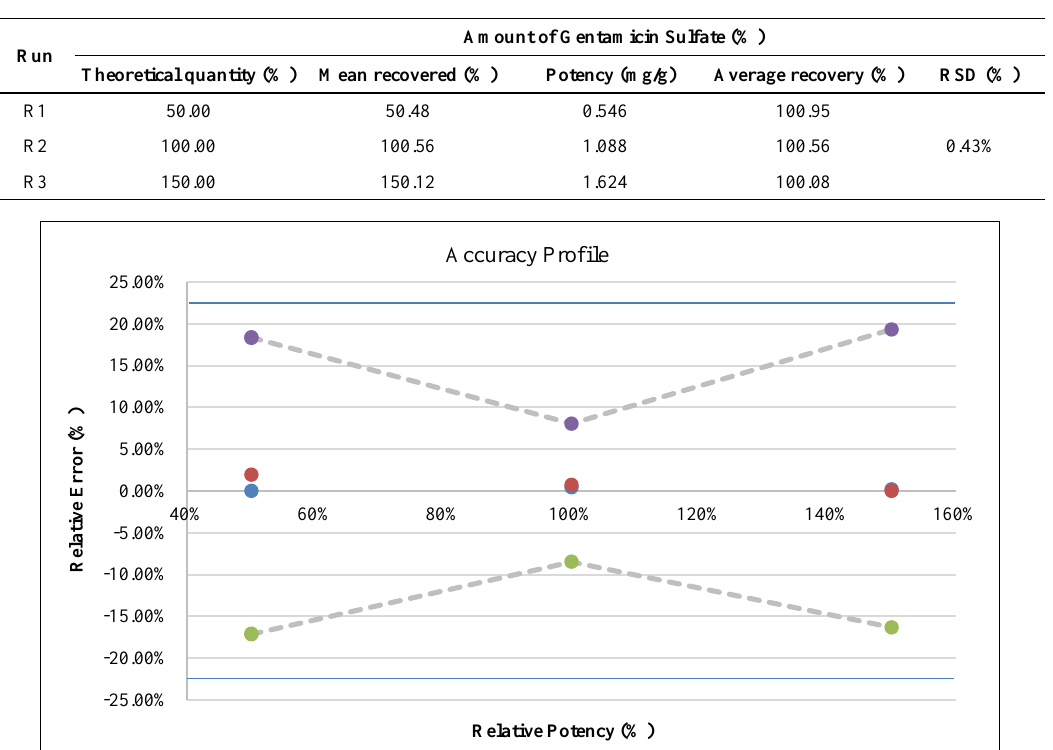
Table 2. Accuracy of PLM microbiological assay of Gentamicin Sulfate in 8×8 rectangular plate